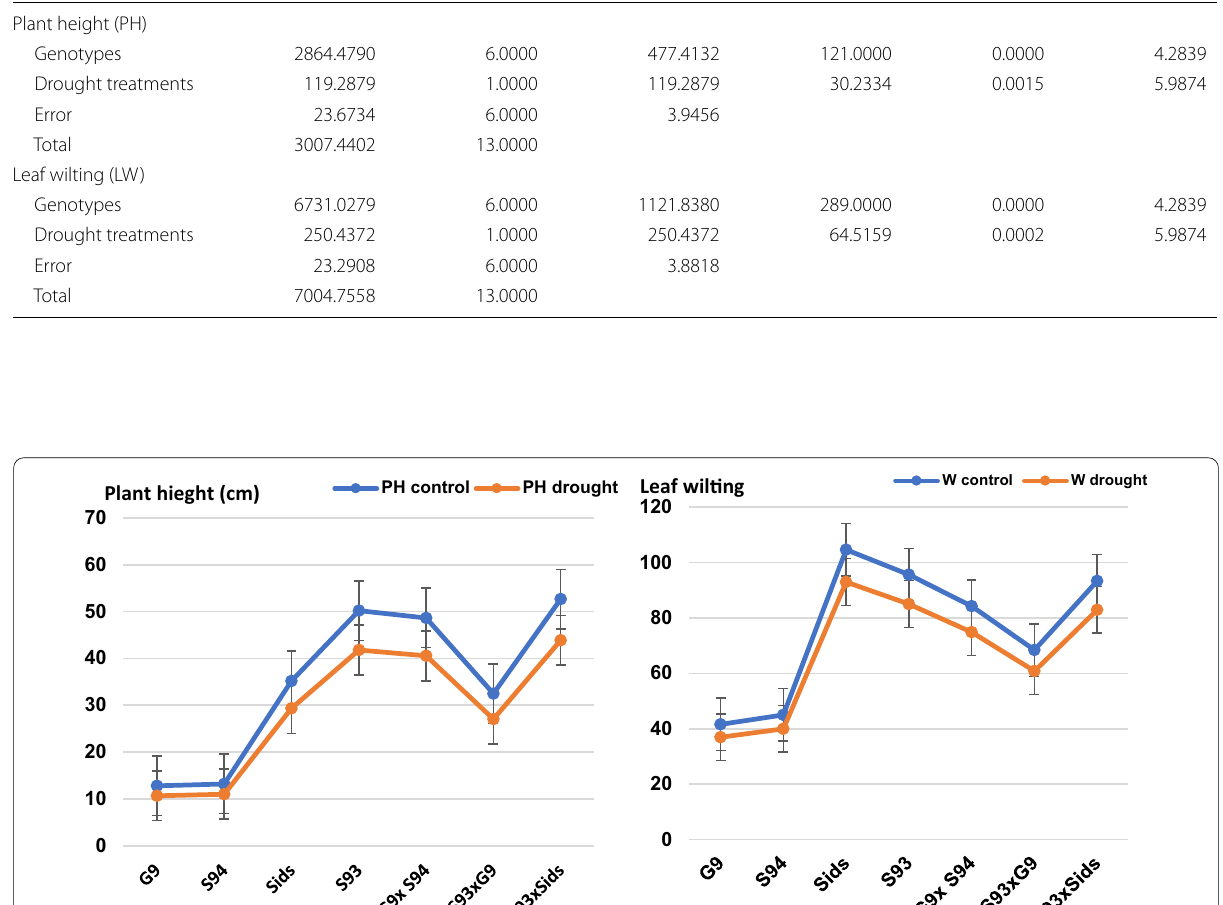
Table 3 Analysis of variance (ANOVA) of plant height (PH) and leaf wilting (LW) Source of variation